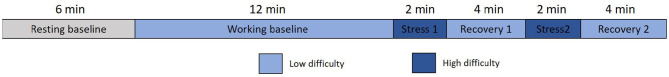
Experimental design detailing the temporal properties and task difficulty of the six phase conditions.